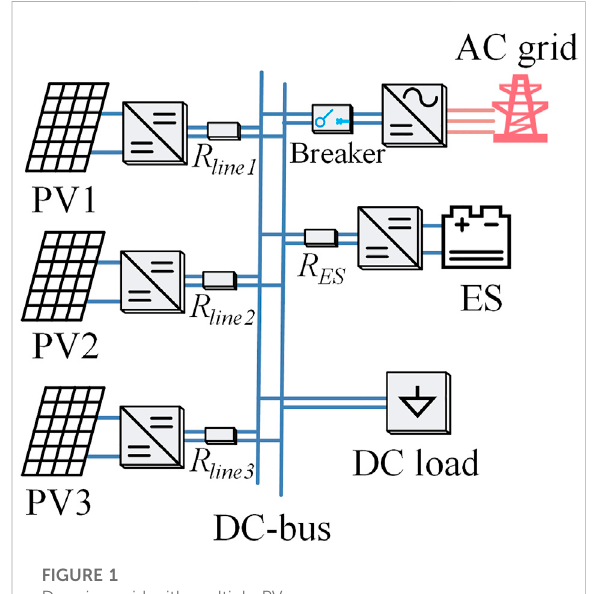
FIGURE 1 Dc microgrid with multiple PV